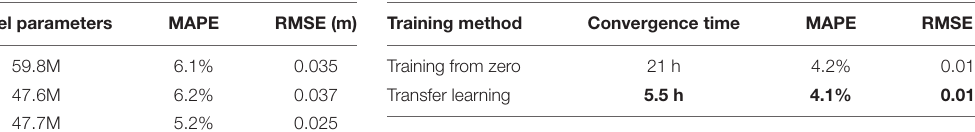
TABLE 2 | Model performance verification.